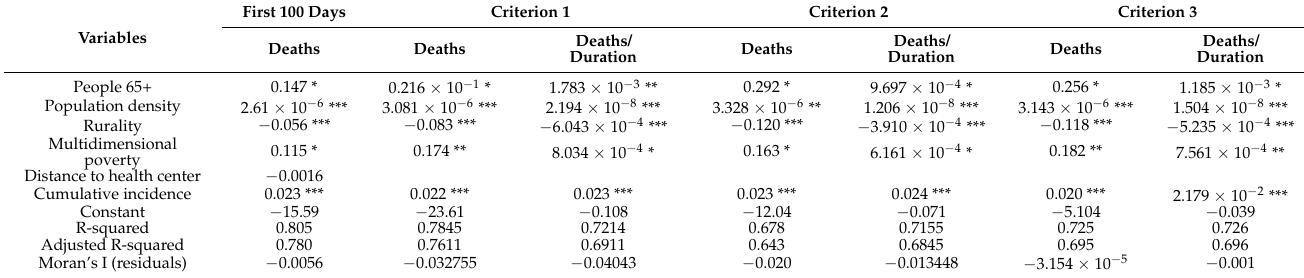
Table 3. OLS regression under different scenarios: death